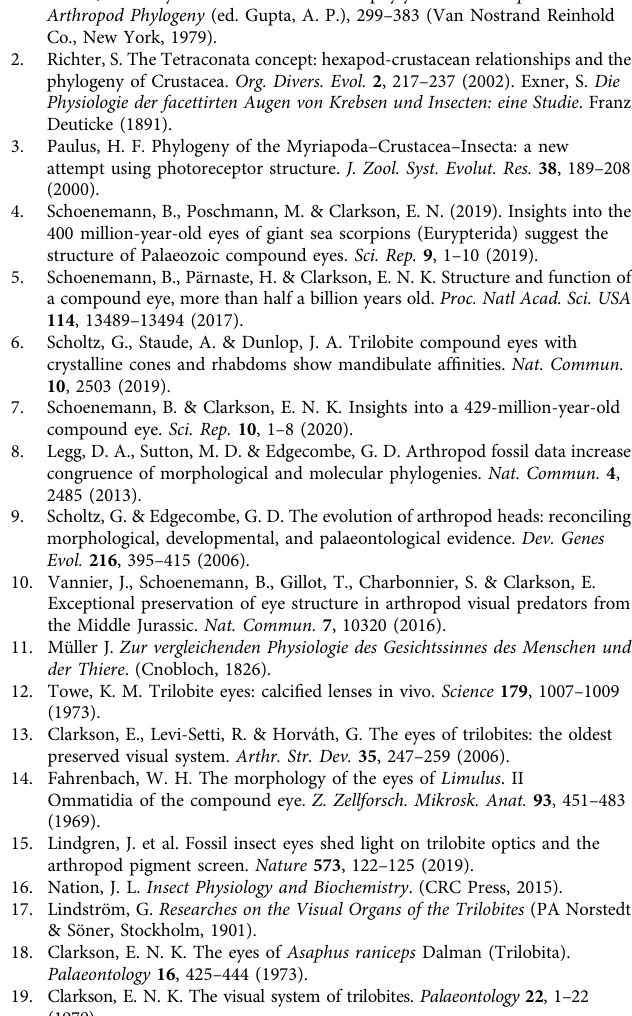
Fig. 2 The optical system of asaphid trilobites. a Asaphus ( Neoasaphus ) expansus (Wahlenberg, 1821), Orthoceras limestone, Ordovician, Sweden [GIK 201]. b Lindström´s drawing (1901) of lenses hollowed out by decay, continuously weathered from the periphery inwards. Second drawing: View on top of the relics of the lenses, which are fi lled with dark mud 17 . c , d [ = Fig. 2f, g 6 ] The same specimen, black arrows from Fig. 2f 6 indicate spine-shaped relics of e [ = Fig. 3f 6 ] Archegonus wahrsteiniensis , blue arrow and yellow curly bracket, added to the original fi gure, indicate atypical structure; red curly